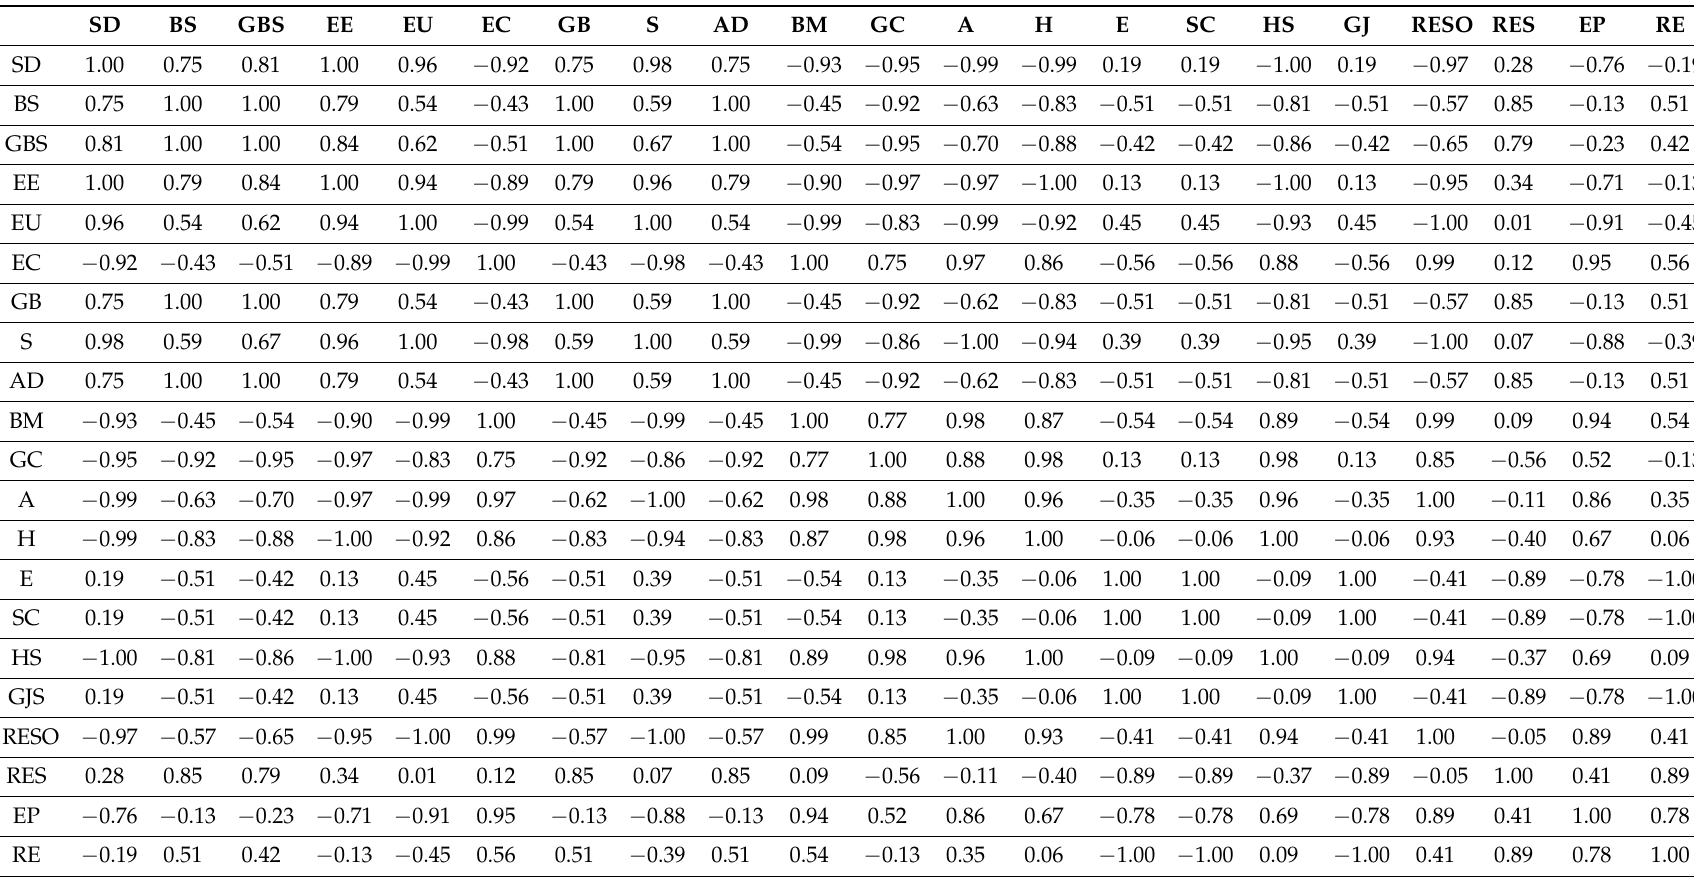
Table 5. Correlations between the most frequently addressed